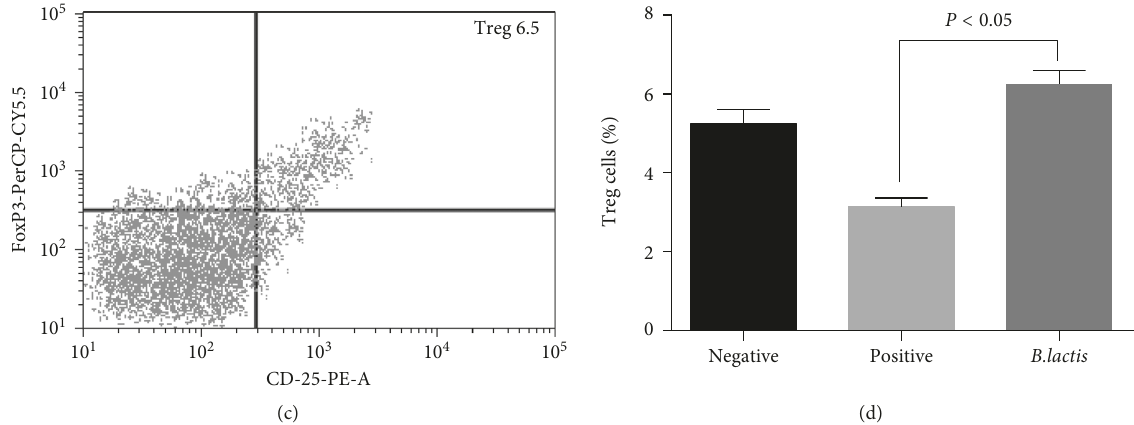
Figure 6: The effects of B. lactis on the percentage of Treg cells in mouse allergy models. (a) The percentage of Treg cells in the NG. (b) The percentage of Treg cells in the PG. (c) The percentage of Treg cells in the EG. (d) The effects of B. lactis on the percentage of Treg cells. BALB/c mice were randomly divided into 3 groups ( n 8 in each group): negative control group (NG), positive control group (PG), and experiment (cid:31) group (EG). The mice from PG and EG were individually immunized with tropomyosin and cholera toxin. The mice from NG received cholera toxin in PBS. Subsequently, the mice from EG received B. lactis . CD4 + T cells were gated by CD4 expression and forward scatter characteristics. The statistical difference was significant if P 0 . 05. < TH17 1.0